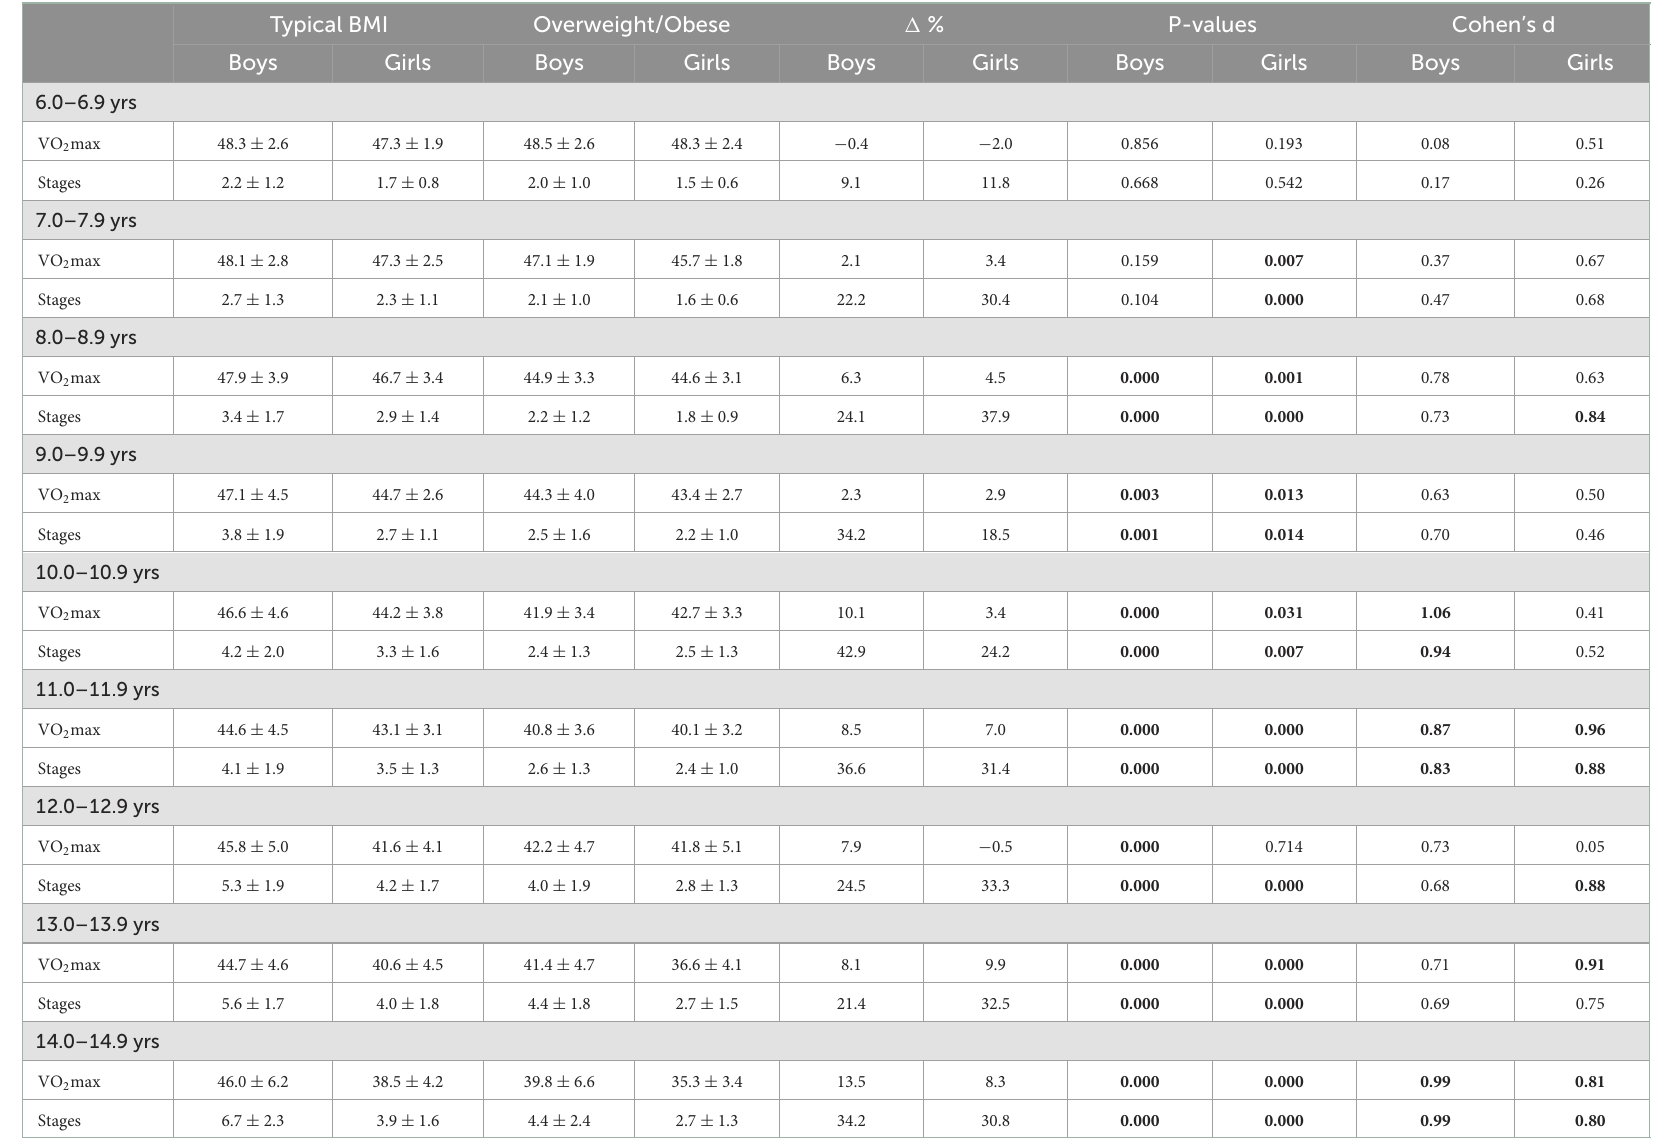
TABLE 4 Comparison of VO 2 max and the number of stages completed in children and adolescents with typical or overweight/obese BMI